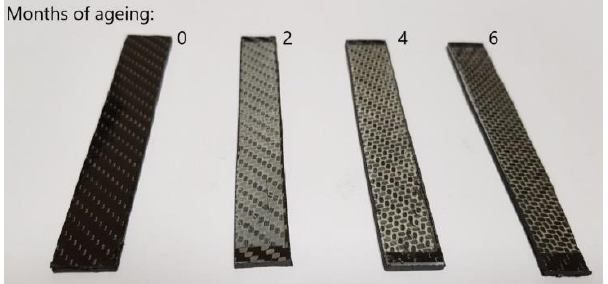
Figure 2. Condition of visual samples after the process of accelerated weathering. From the left, the samples corresponding to 0, 2, 4, and 6 months of use.